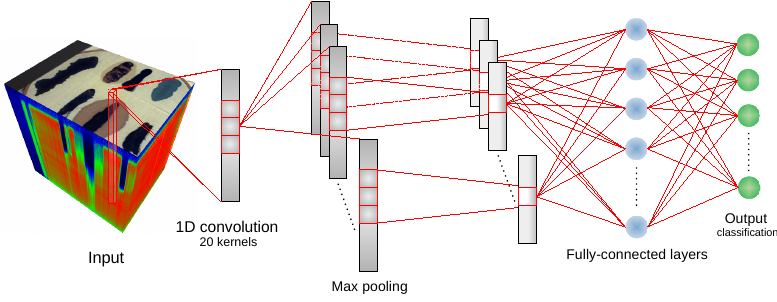
Figure 4. Schematic of the 1D CNN architecture [10] used in experiments.